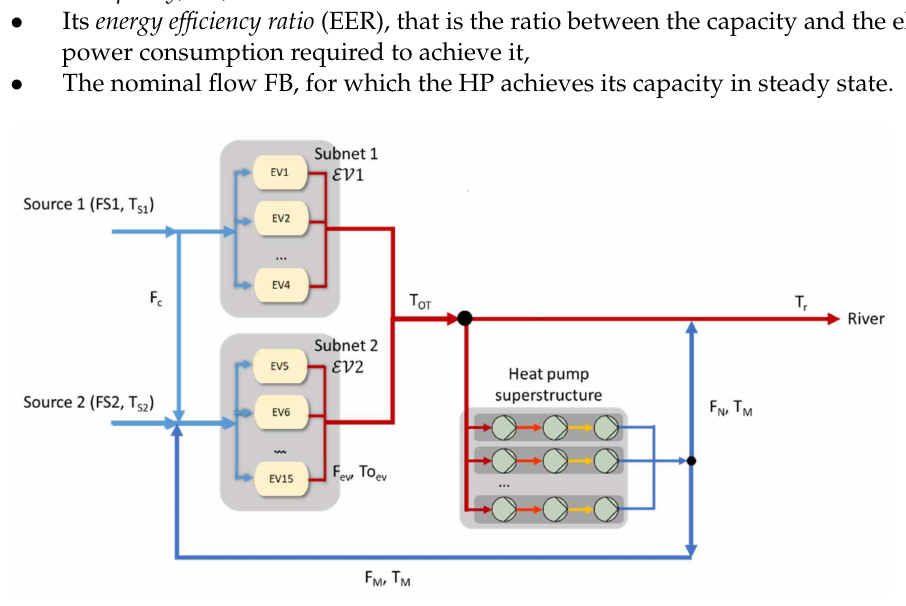
Figure 2. Layout of the cooling system with the superstructure of HPs incorporation (all symbols defined in Section